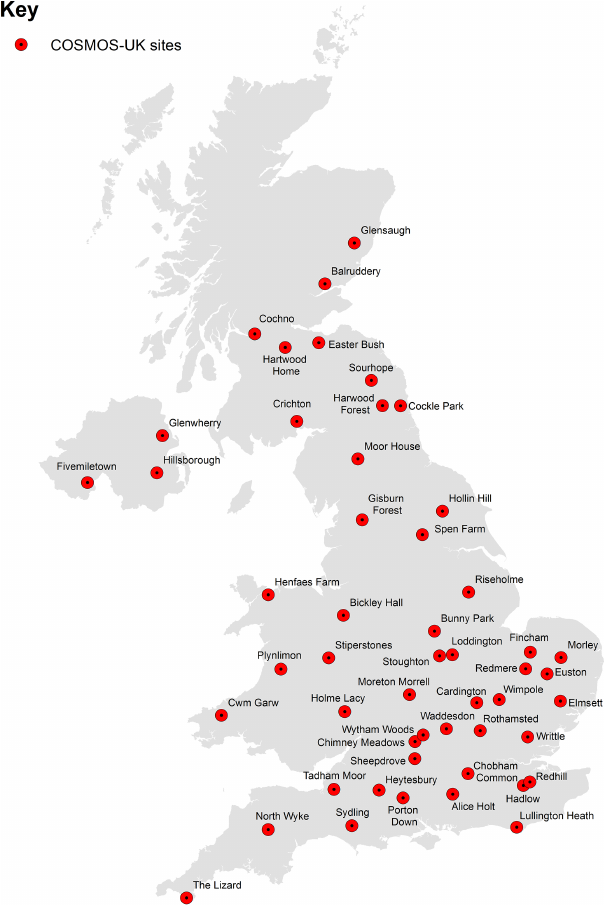
Figure 1. Map of COSMOS-UK site locations (Boorman et al.,